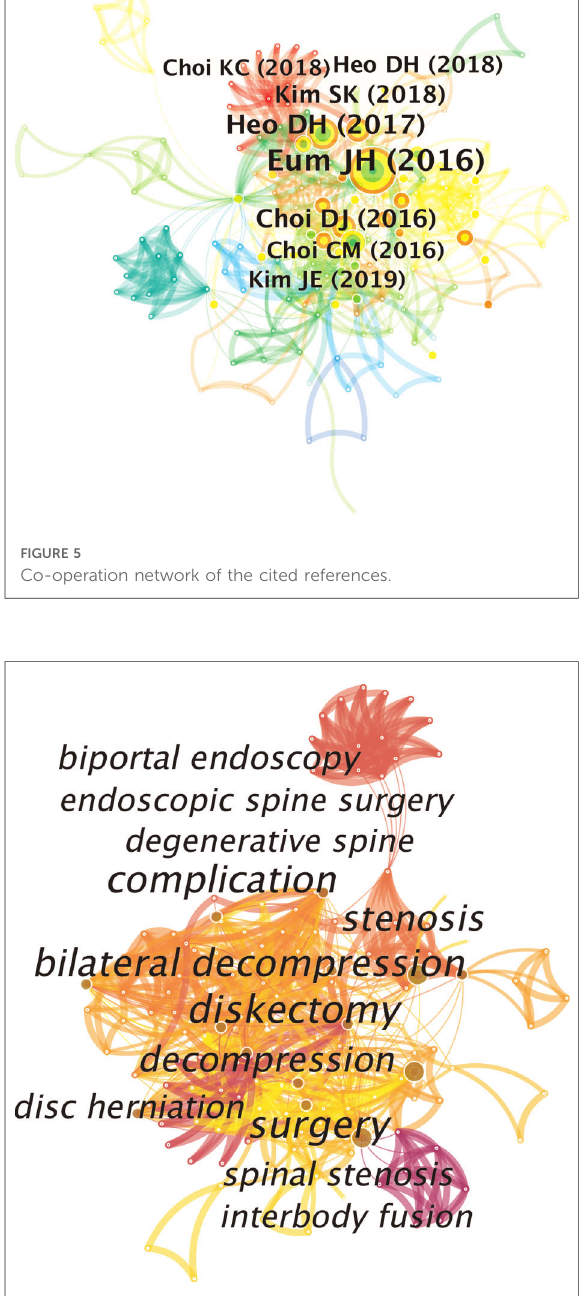
FIGURE 6 Co-operation network of the